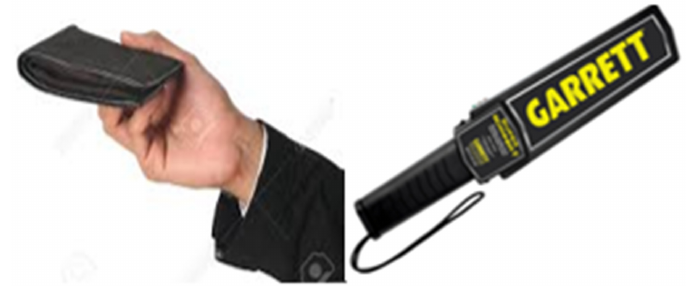
Figure 1. Data samples for pistol category.